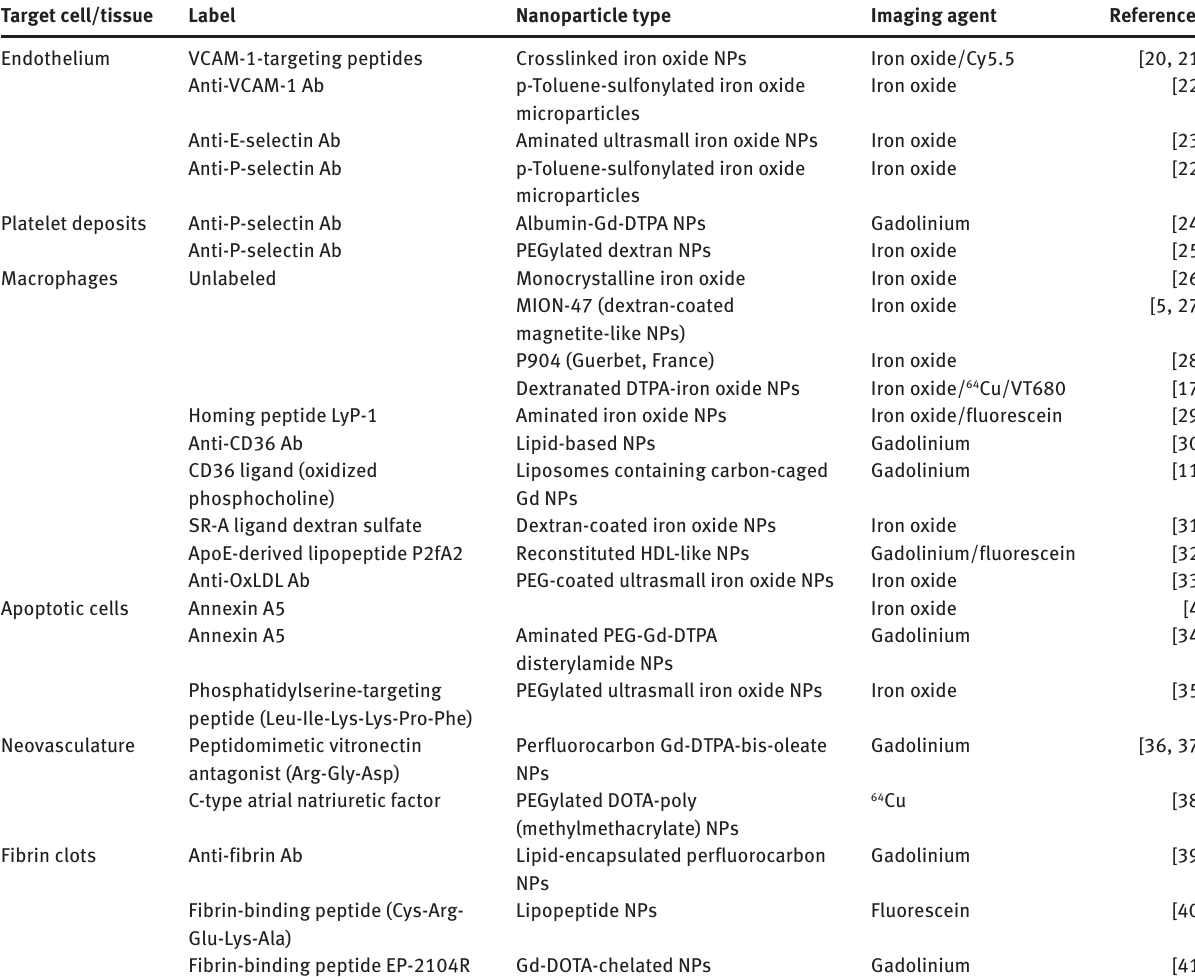
Table 1 The diagnostic targets of the nanoparticles in the cardiovascular disease. Target